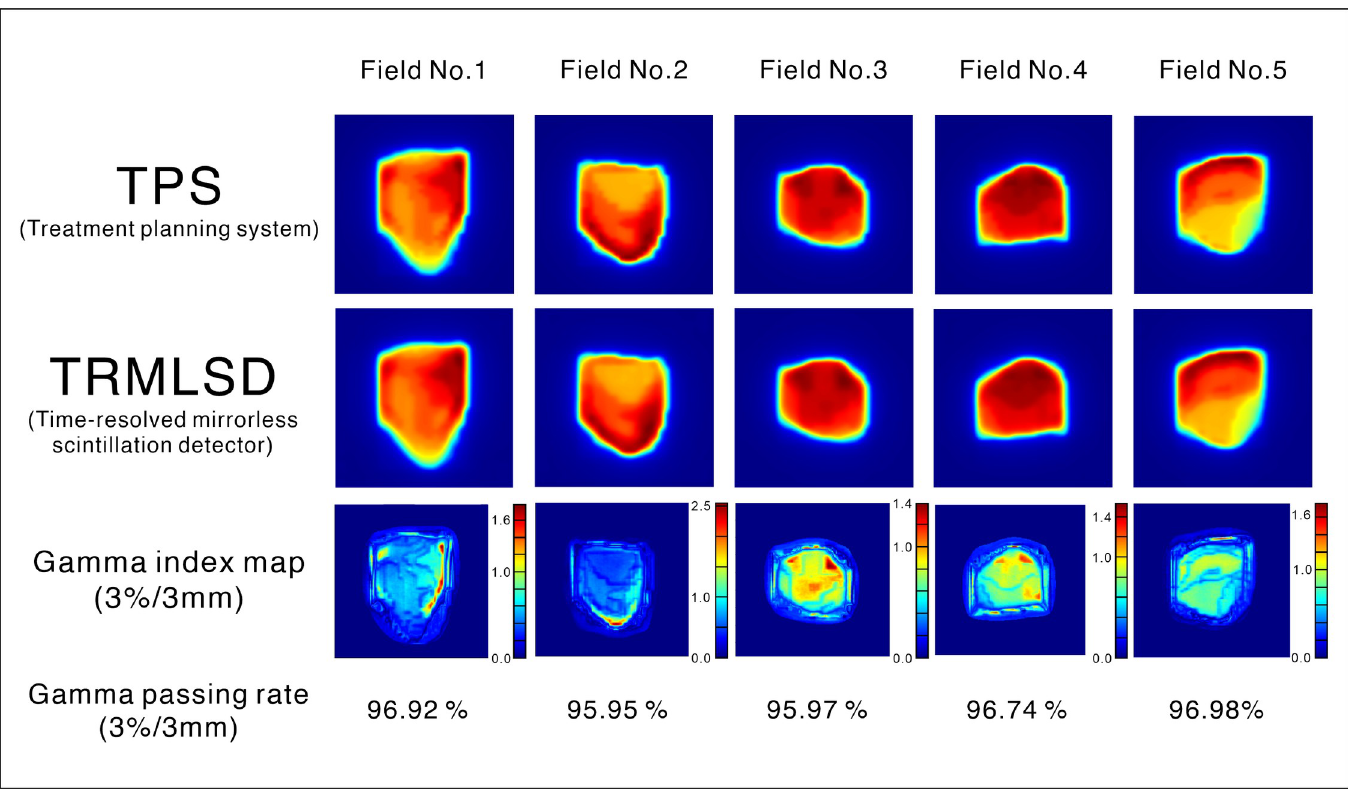
Fig 15. Each column represents a different field in the clinical liver IMRT case. The first row shows the normalized 2D dose distribution calculated by the treatment planning system (TPS). The second row shows the normalized 2D dose distribution acquired using the TRMLSD. The third row shows the gamma index maps with the passing rates for each plan. A 3%/3 mm gamma criteria suppressing 5% of the maximum dose and global normalization were used. The TPS data were used as the reference dataset for comparison.